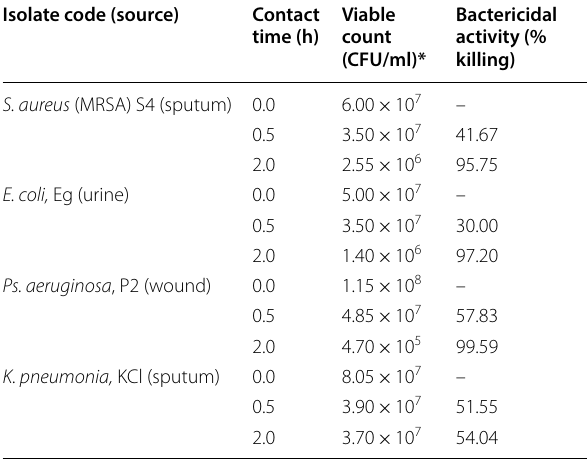
* CFU/ml obtained from average of three determinations carried out by surface viable count method at RT (24 °C)